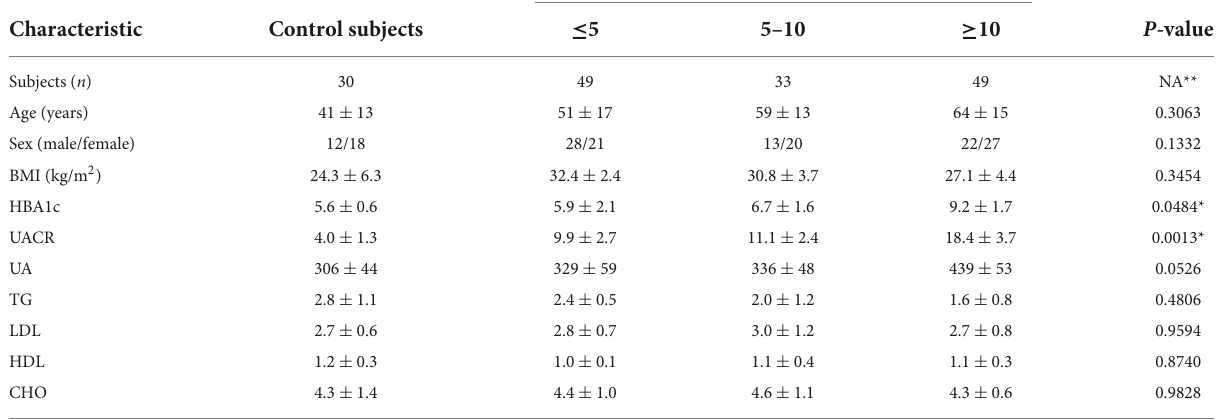
Diabetes duration